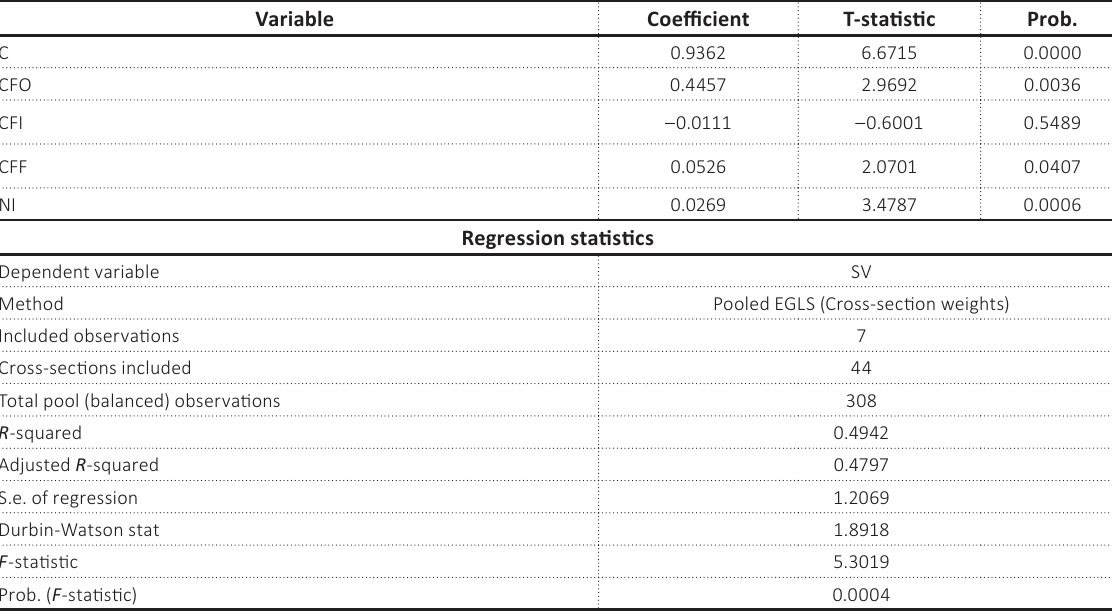
Table 4. Regression analysis results of the study